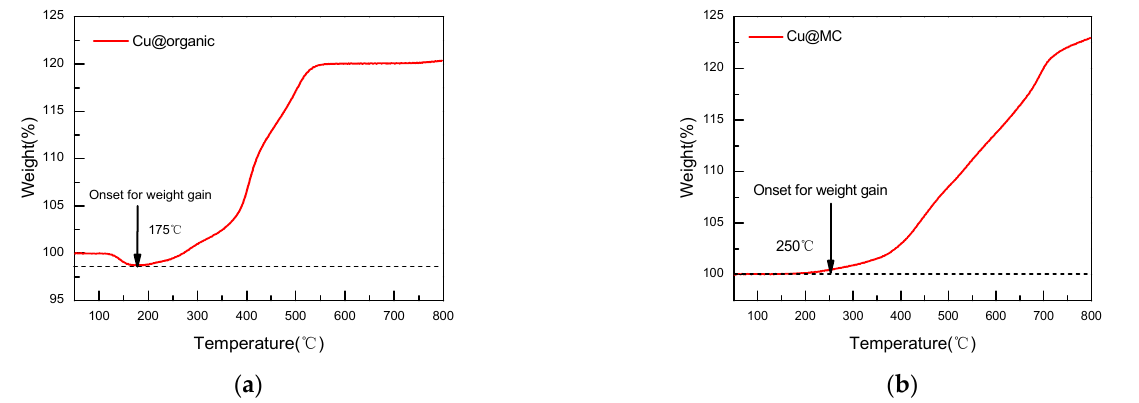
Figure 10. TGA curves of ( a ) Cu@organic; ( b ) Cu@MC under air atmosphere.